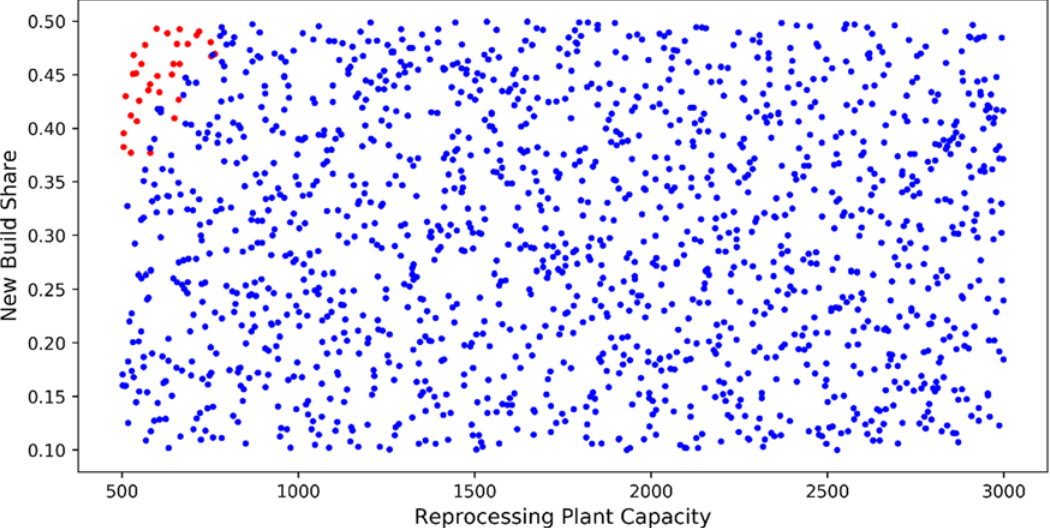
Fig. 6. The sample space of reprocessing capacity for each of the two plant types and the advanced reactor new build share at the end of the simulation. (RED – fuel shortage, BLUE – successful